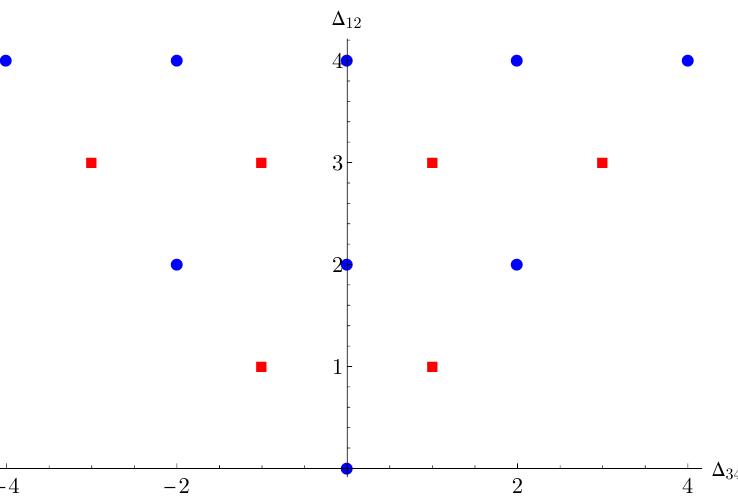
Figure 1 . Parameters of scalar conformal blocks for the even-even (blue dots) and odd-odd (red squares)